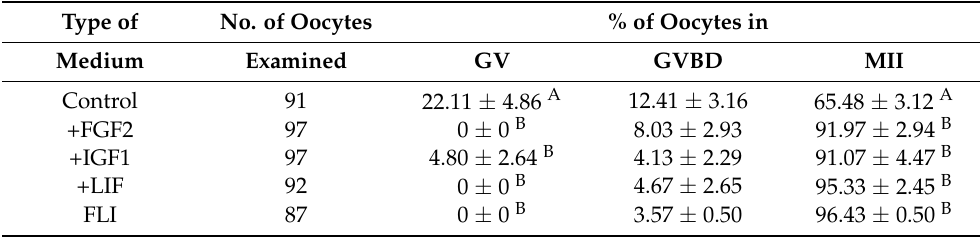
Table 2. Effect of FGF2, LIF and IGF1 on maturation of porcine oocytes in vitro. Type of No. of Oocytes % of Oocytes in